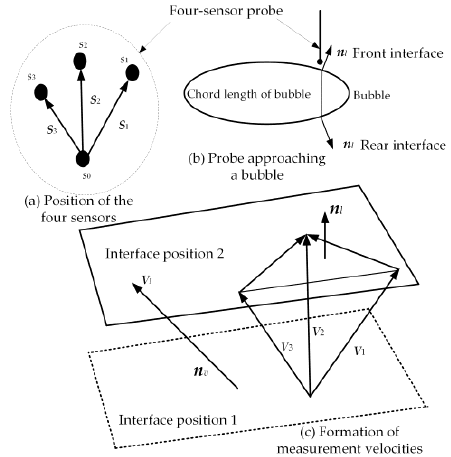
Figure 5. Measurement principle of four-sensor probe. ( a ) Position of the four sensors; ( b ) Probe approaching a bubble; ( c ) Formation of measurement velocities.